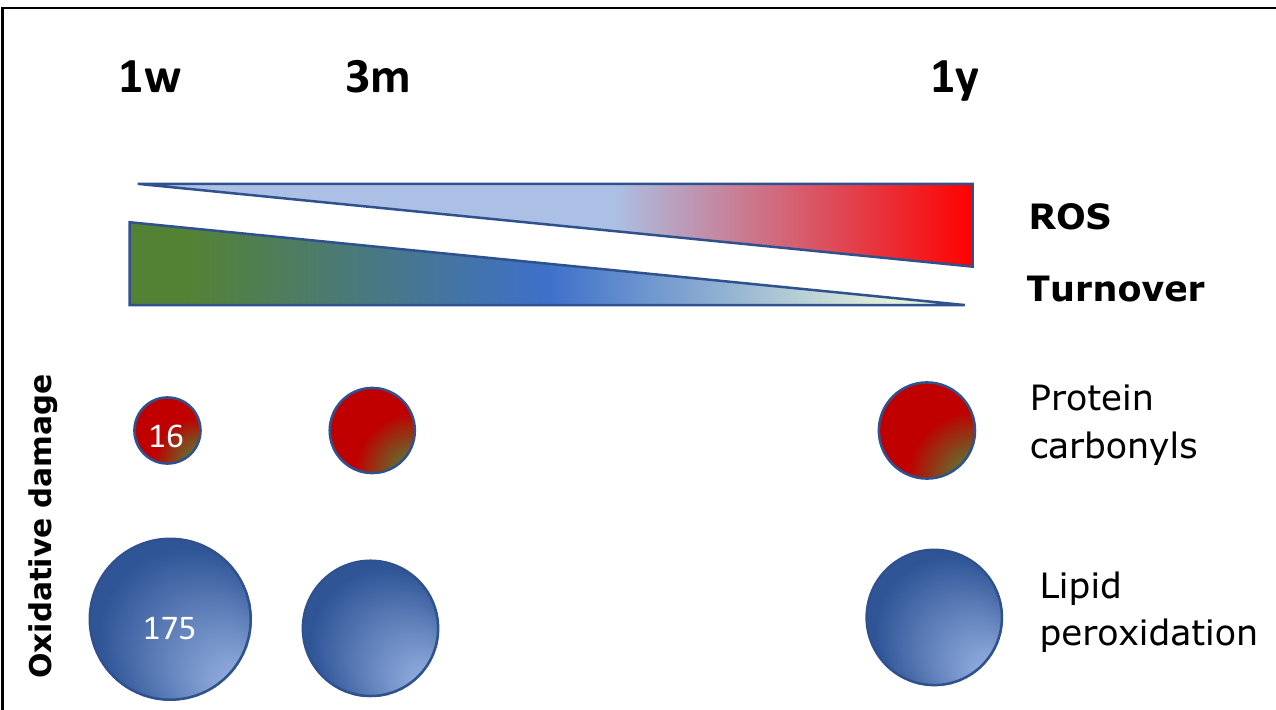
Figure 4. Oxidative stress is a driving force for homeostatic turnover in mouse heart. Total